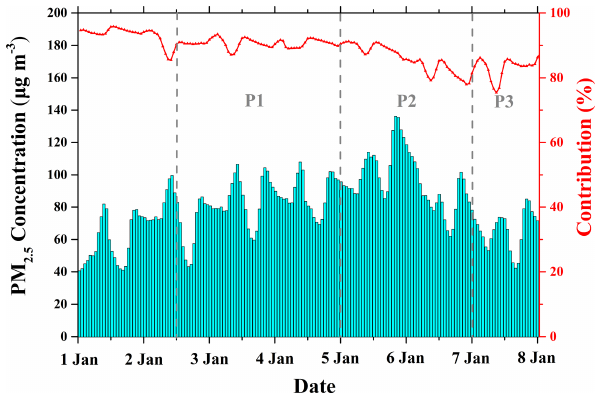
Figure 11. Hourly variations of surface PM 2 . 5 concentrations orig- inating from the SCB’s anthropogenic emissions (blue filled areas) and the contribution proportions to the basin surface PM 2 . 5 levels (red curve) during 1–7 January 2017 based on the regional averages over the